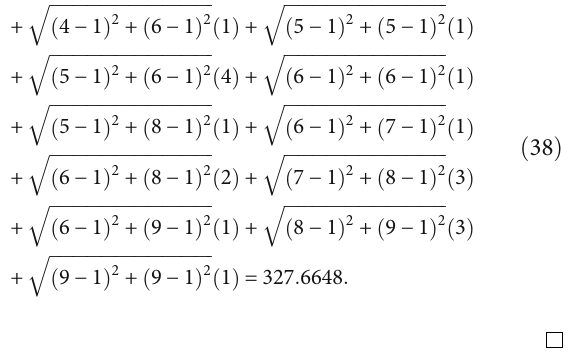
ffiffiffiffiffiffiffiffiffiffi 4 × 5